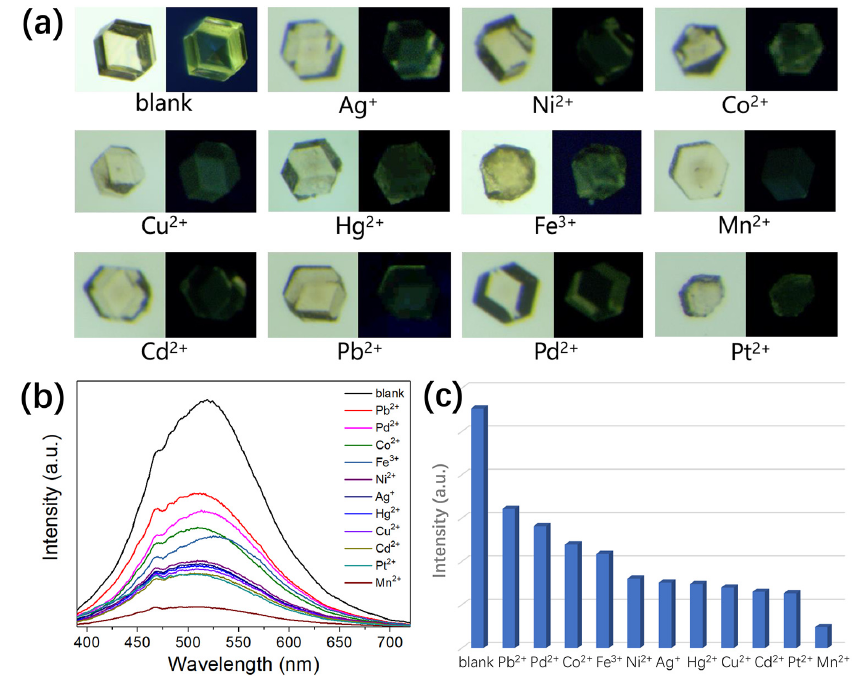
Figure 4. ( a ) Photographs of ZnBPD-4F4TS crystals under natural light and 365 nm UV light irradiation after immersion in water and aqueous solution of different metal ions (500 ppm). ( b ) Room temperature emission spectra ( λ ex = 370 nm) of ZnBPD-4F4TS after immersion in water and aqueous solution of different metal ions (500 ppm). ( c ) Emission intensity data at 518 nm according to the spectra from ( b ).